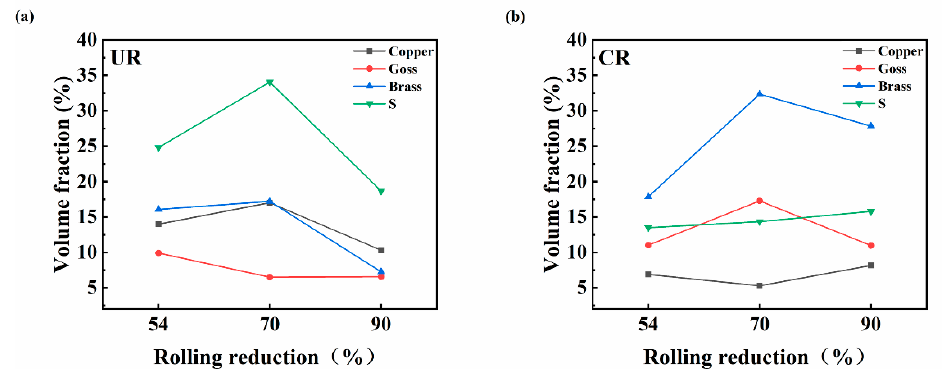
Figure 6. The volume fraction of rolling texture components in the differently rolled samples of Cu-0.1Al alloy: ( a ) UR sample; ( b ) CR sample.